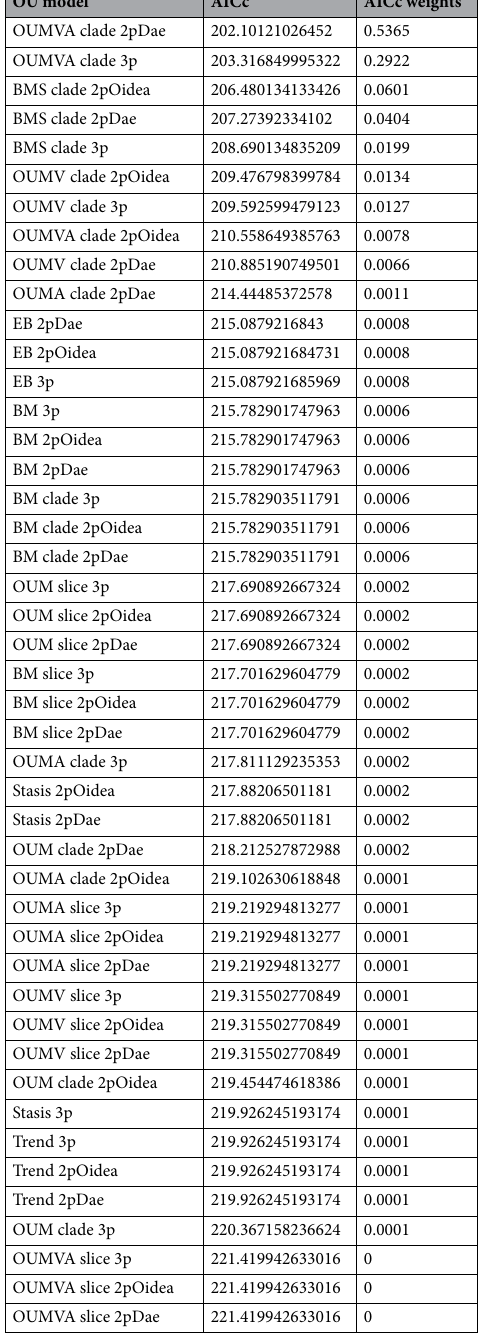
Table 1. AIC evaluation of model performance on the different evolutionary models run for best fit on the Phylogeny of Ornithischia updated to the topology recovered in this study and the new body size data reported herein for Tethyshadros . Symbols and abbreviations: BM, Brownian motion; clade, models with different parameters for each clade; EB, early boost (high σ at the base of the tree); slice, a model with a significant shift at a given time slice, here selected at 93.9 million years ago (Cenomanian/Turonian boundary); Stasis, a model with strong α towards a given θ; OU, Ornstein–Uhlenbeck; OUM, multi ‐ peak OU model (multiple regimes within individual θ values) with fixed values of α and σ; OUMV, multi ‐ peak OU model with fixed values of α and σ as a free parameter; OUMA, multi ‐ peak OU model with fixed values of σ and α as a free parameter; OUMVA, multi ‐ peak OU model with both σ and α as free parameters; Trend, a model following a given linear trend (given α constant). Partitioned models are abbreviated as: 3p, three portioned model with Hadrosauridae, Hadrosauroidea and non-hadrosauroid Ornithischia; 2pDae, two partitioned model with Hadrosauridae and non-hadrosaurid Ornithischia; 2pOidea, two partitioned model with Hadrosauroidea and non-hadrosauroid